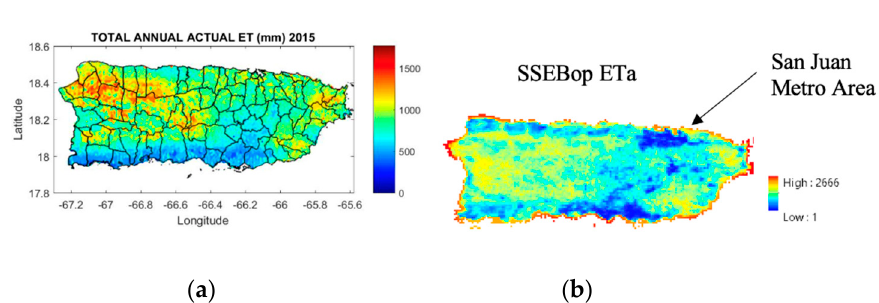
Figure 12. Spatial distribution of ETa estimated from GOES-PRWEB ( a ) and SSEBop ( b ).